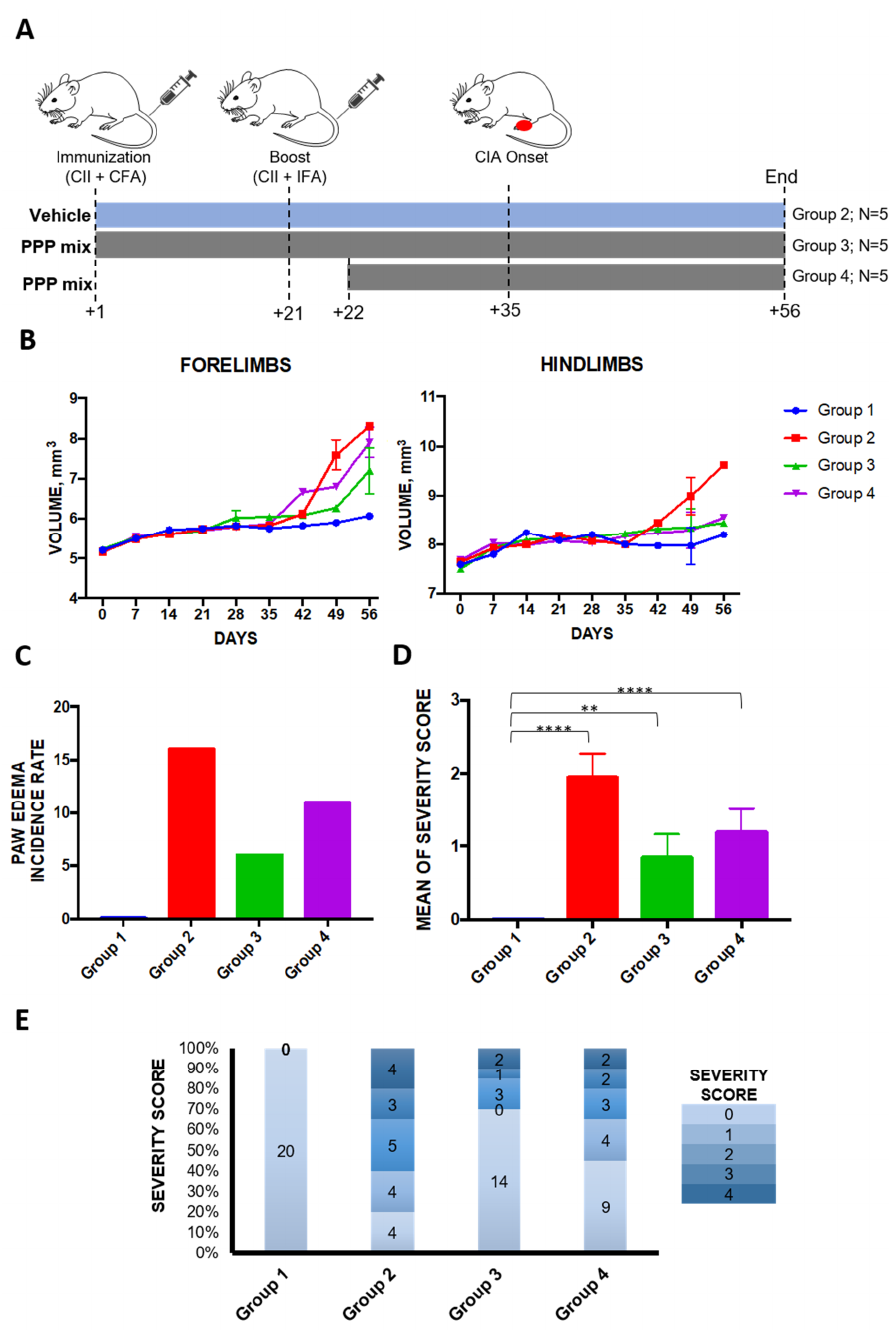
Figure 3. Treatment with PPP (propolis, pomegranate, and grape pomace) mixture ameliorates the pathology of collagen-induced arthritis (CIA). ( A ) Timetable of CIA induction and treatment strategies in type II collagen (CII)-immunized DBA / 1J mice. All mice were sacrificed on day 56 post immunization. ( B ) The average forepaw and hindpaw volumes were measured in each experimental group. ( C ) Incidence of rheumatoid arthritis (RA) (number of paws showing clinical sympthoms). ( D ) Severity score observed in each experimental group (mean ± SEM). ( E ) Distribution of the severity scores among the experimental groups. Data are from n = 5 mice / group (n = 20 paws / group). ** p < 0.01; **** p < 0.0001, as calculated by one-way ANOVA. CII = collagen II; CFA = Complete Freund Adjuvant; IFA = Incomplete Freund